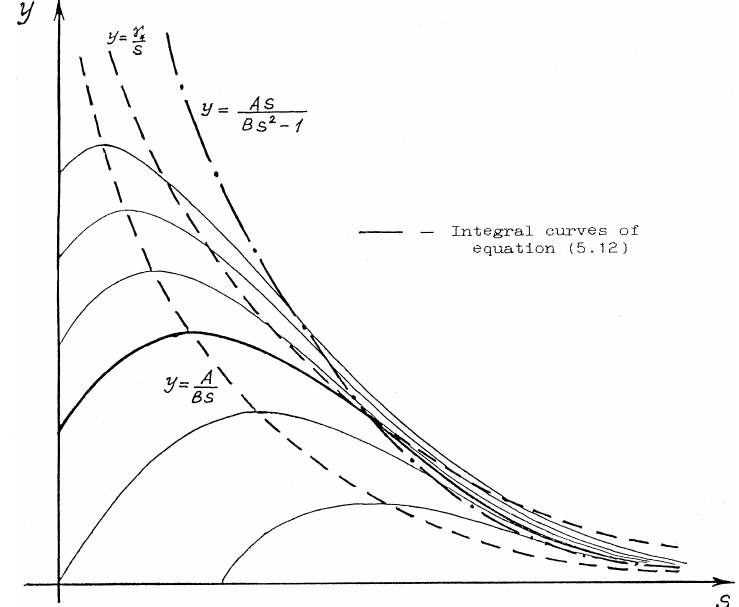
Figure 7. Integral curves corresponding to solutions of Equation (38) together with the hyperbolas y = A / ( BS ) , on which the integral curves attain their maximum, y = γ ∗ / S and y = AS / ( BS 2 − 1 ) , on which the integral curves have their inflection